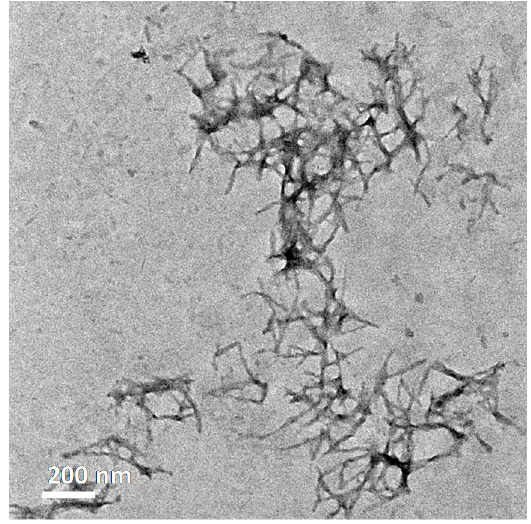
Figure A2. TEM image of A β (1–42) after incubation at 37 °C for 375 h in 100 mM aqueous ammonium acetate, at a magnification of 12000 X, using a peptide concentration of 12.5 μ M and a CuSO 4 concentration of 12.5 μ M.